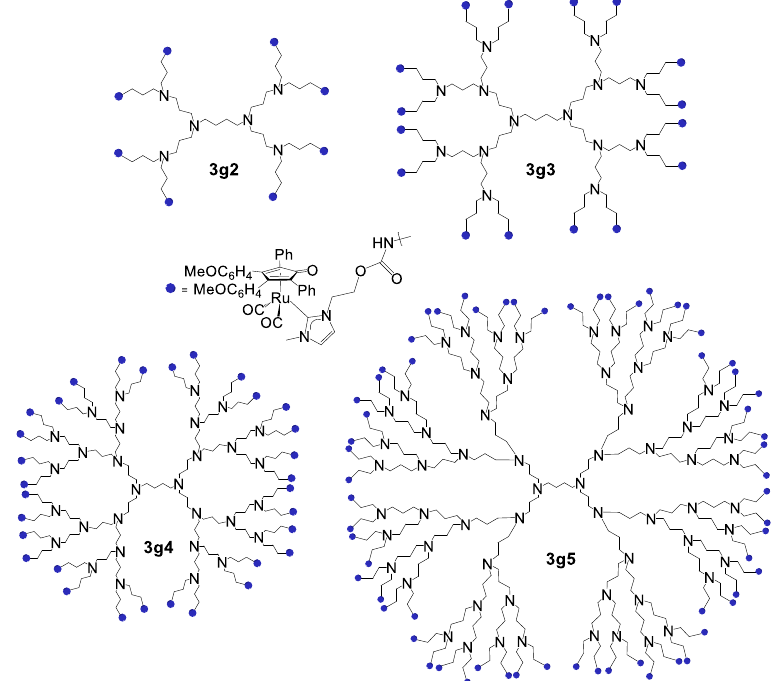
Figure 2. Structure of the second-to-fifth generation dendrimers functionalized with n ruthenium(0) complexes: 3g2 ( n = 8), 3g3 ( n = 16), 3g4 ( n = 32) and 3g5 ( n = 64).